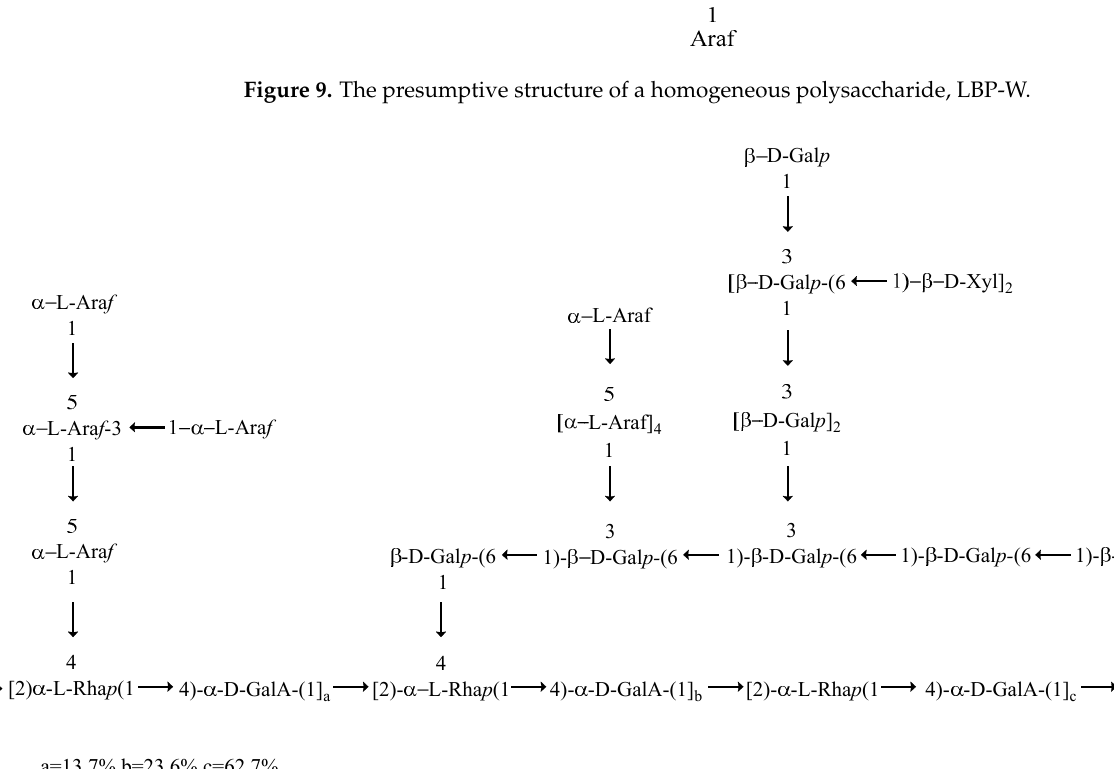
Figure 11. One of possible structure of the repeat unit of LbGp4-OL.